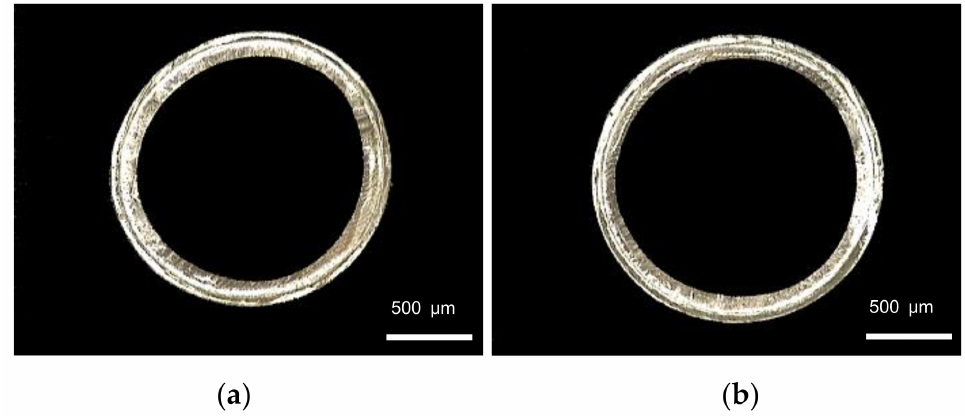
Figure 17. The cross section of micro tubes at different vacuum degrees: ( a ) Vacuum degree = 0 inH 2 O; ( b ) Vacuum degree = 45 inH 2